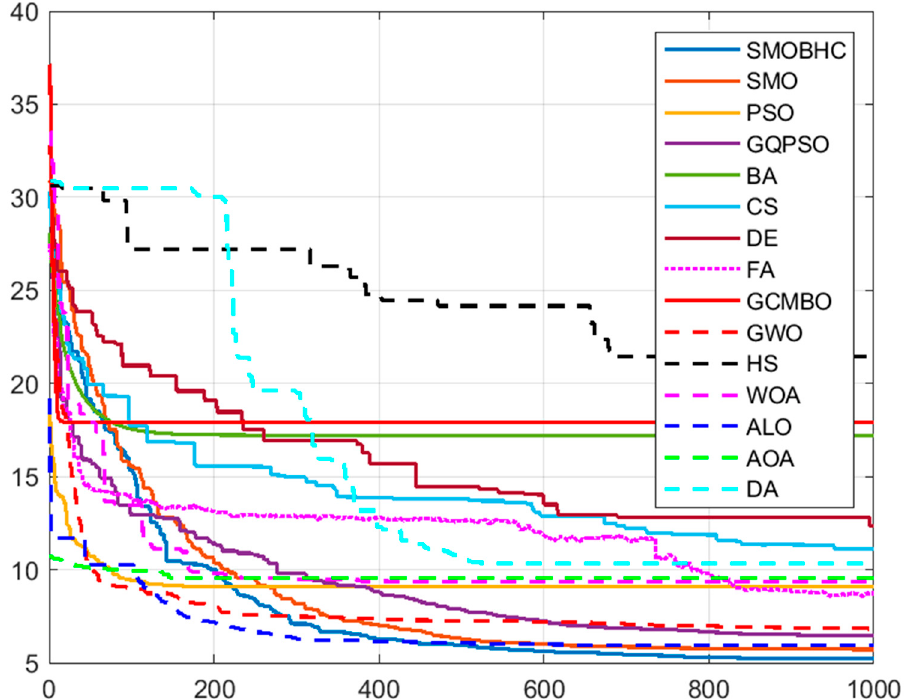
Figure 10. Comparative convergence curves of algorithms for battlefield 1 with 𝐷 = 90 .